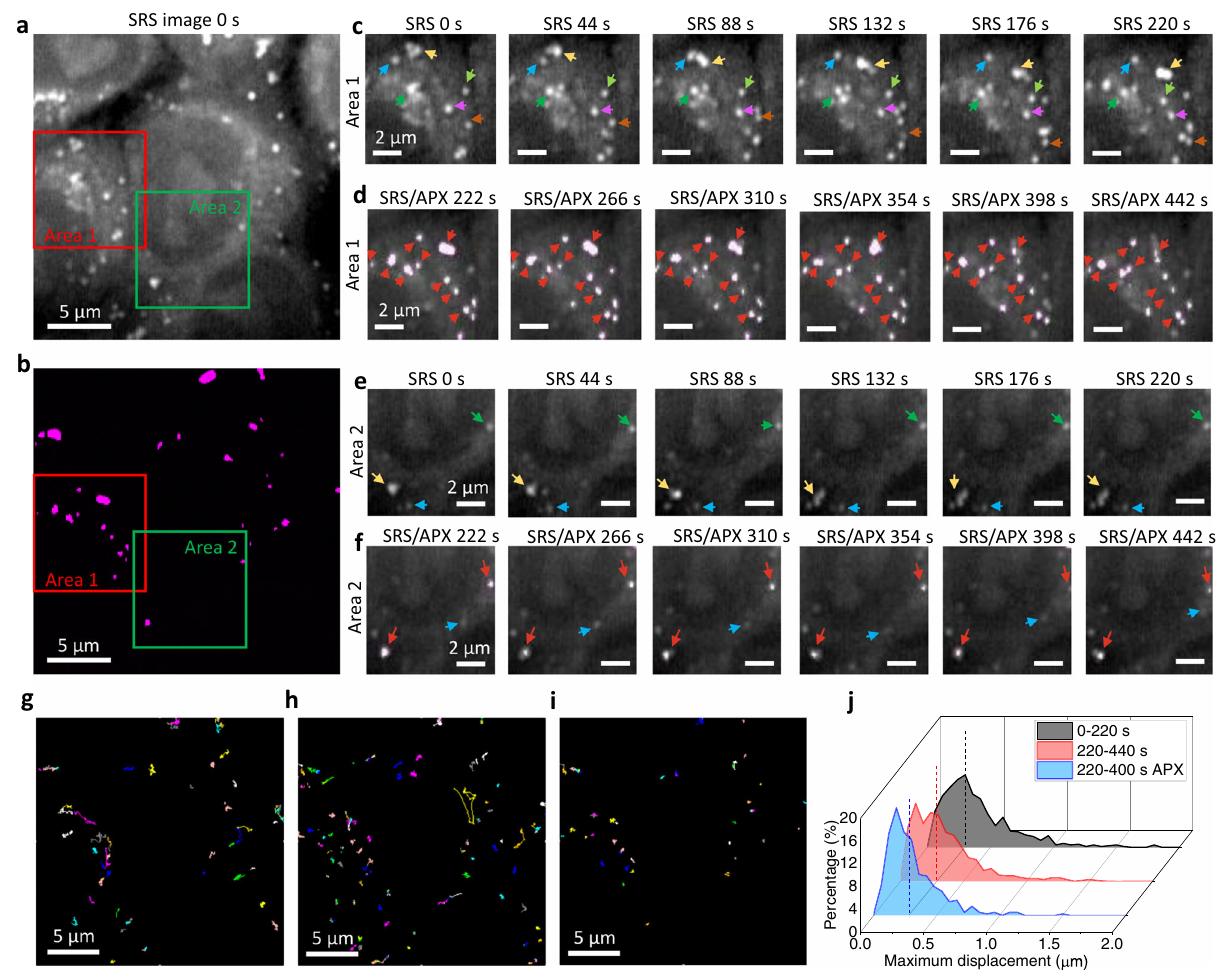
Fig.8|Precisioncontroloflipiddroplet(LD)dynamicsinliveKyotoHeLacells. a Astimulated Ramanscattering (SRS)image of Kyoto HeLacells attime 0. b Active pixels (APXs) from the same fi eld of view at time 222s. c Time-lapse SRS images of LDs from time 0s to 220s for Area 1 in panel a . Arrows showing dynamics of LDs in cells. d OverlaysofSRSimagesandAPXsfromtime 222sto442sforArea1inpanel a .ArrowsshowreducedLDdynamicsduringRPOC. e , f Time-lapseimagessimilarto